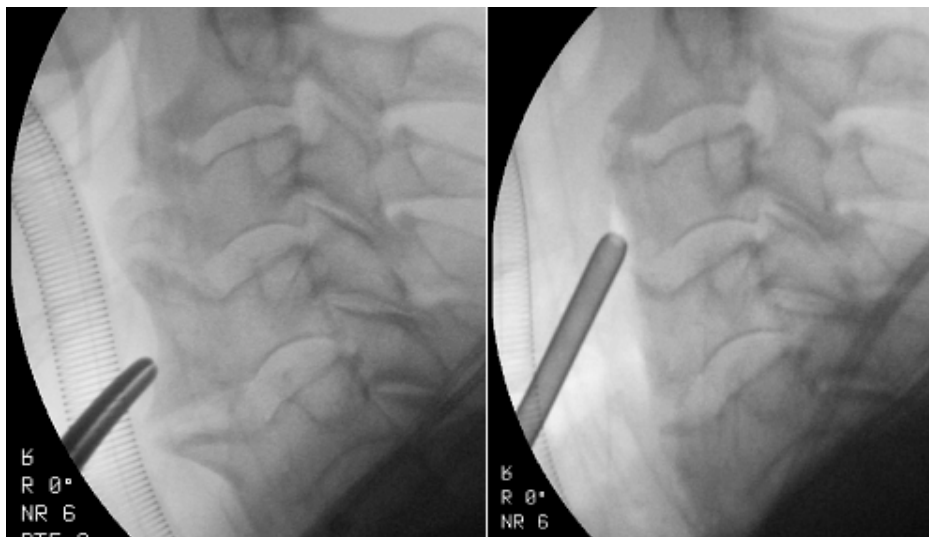
Figure 2. Intraoperative fluoroscopic imaging before and after osteophyte removal in a 72-year-old patient with DISH with dysphagia.